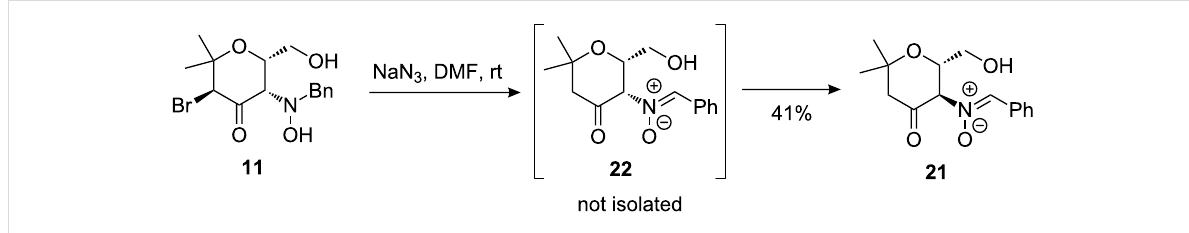
Scheme 11: Transformation of α -bromoketone 11 into nitrone 21 .